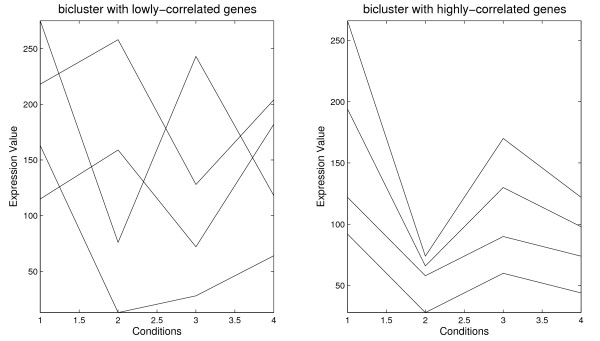
Correlation among genes. Biclusters with lowly-correlated genes and highly-correlated genes[1151597218216313286421825812820427576243118]⇒ρ(B)=0.003[19466130989228604426674170122122589074]⇒ρ(B)=1